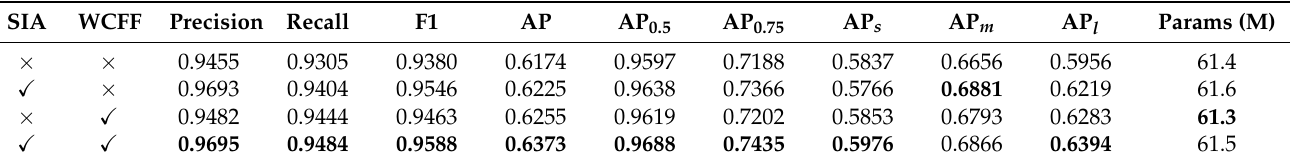
Table 3. Performance of each feature enhancement module in our ATSD on the SSDD